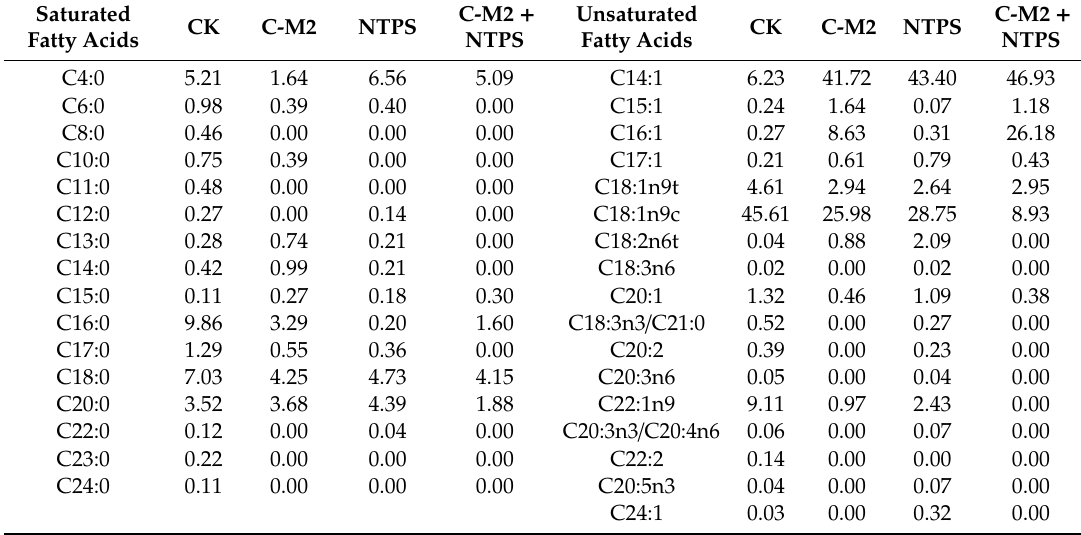
Table 1. Fatty acid composition (%) in cell membranes of Morganella sp.wf-1 by different treatments.